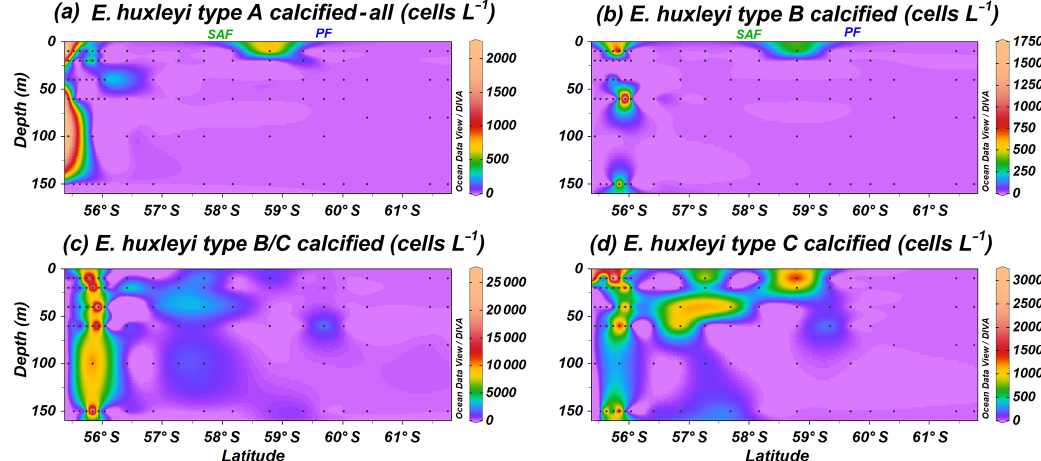
Figure 10. Location of the PS97 CTD stations studied, showing the number of coccospheres per litre of Emiliania huxleyi calcified and overcalcified (a) type A group, (b) type B, (c) type B/C, and (d) type C. The Subantarctic Front (SAF) and the Polar Front (PF), according to Orsi et al. (1995), are